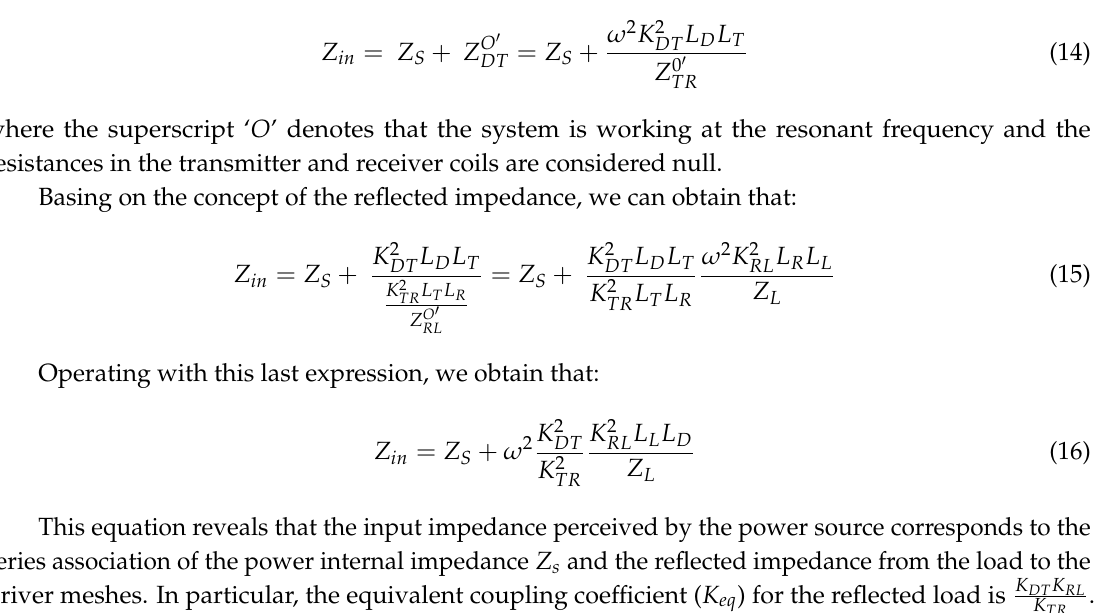
Figure 4. Model of a four-coil scheme as a two-coupled coil scheme operating at resonance.